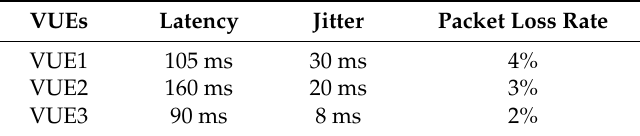
Table 3. The minimum performance requirements of VUEs.